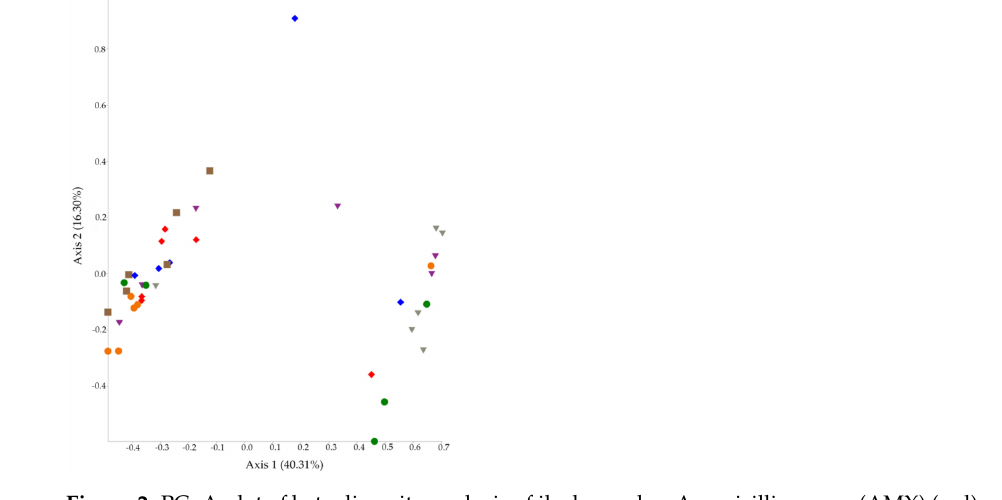
Figure 2. PCoA plot of beta diversity analysis of ileal samples. Amoxicillin group (AMX) (red), amoxicillin + diclazuril group (AMX + DCZ) (blue), thiamphenicol group (THP) (purple), thiamphenicol + diclazuril group (THP + DCZ) (grey), sulfadiazine + trimethoprim group (TRIM) (brown), diclazuril group (DCZ) (orange) and control group (K) (green).